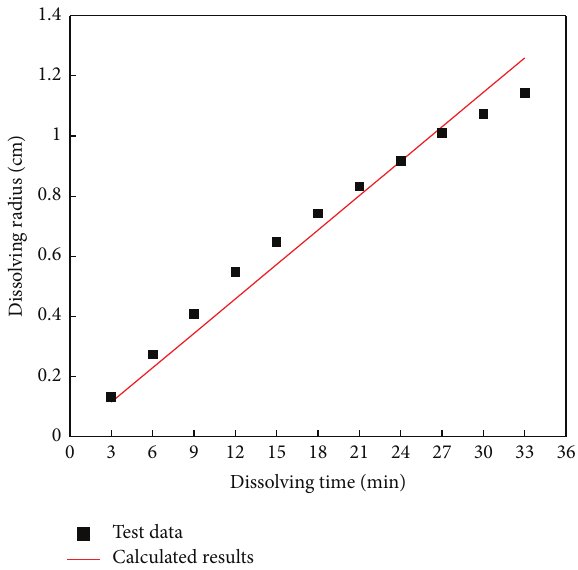
Figure 11: Comparison of the dissolved radius between test data and calculated results under 50